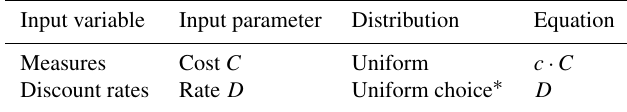
Table B2. Summary of available helper methods to define uncertainty parameter distributions for the additional input variables of CLIMADA required for appraisal of adaptation options. For all distributions, the parameters can be set by the user (e.g. the bounds of the uniform distributions are free parameters). ∗ The discount rate value is sampled uniformly from a list of values. These helper methods are for the convenience of the users only. Any other uncertainty parameter distributions (discrete, continuous, multi-dimensional, etc.) can be defined by the user if